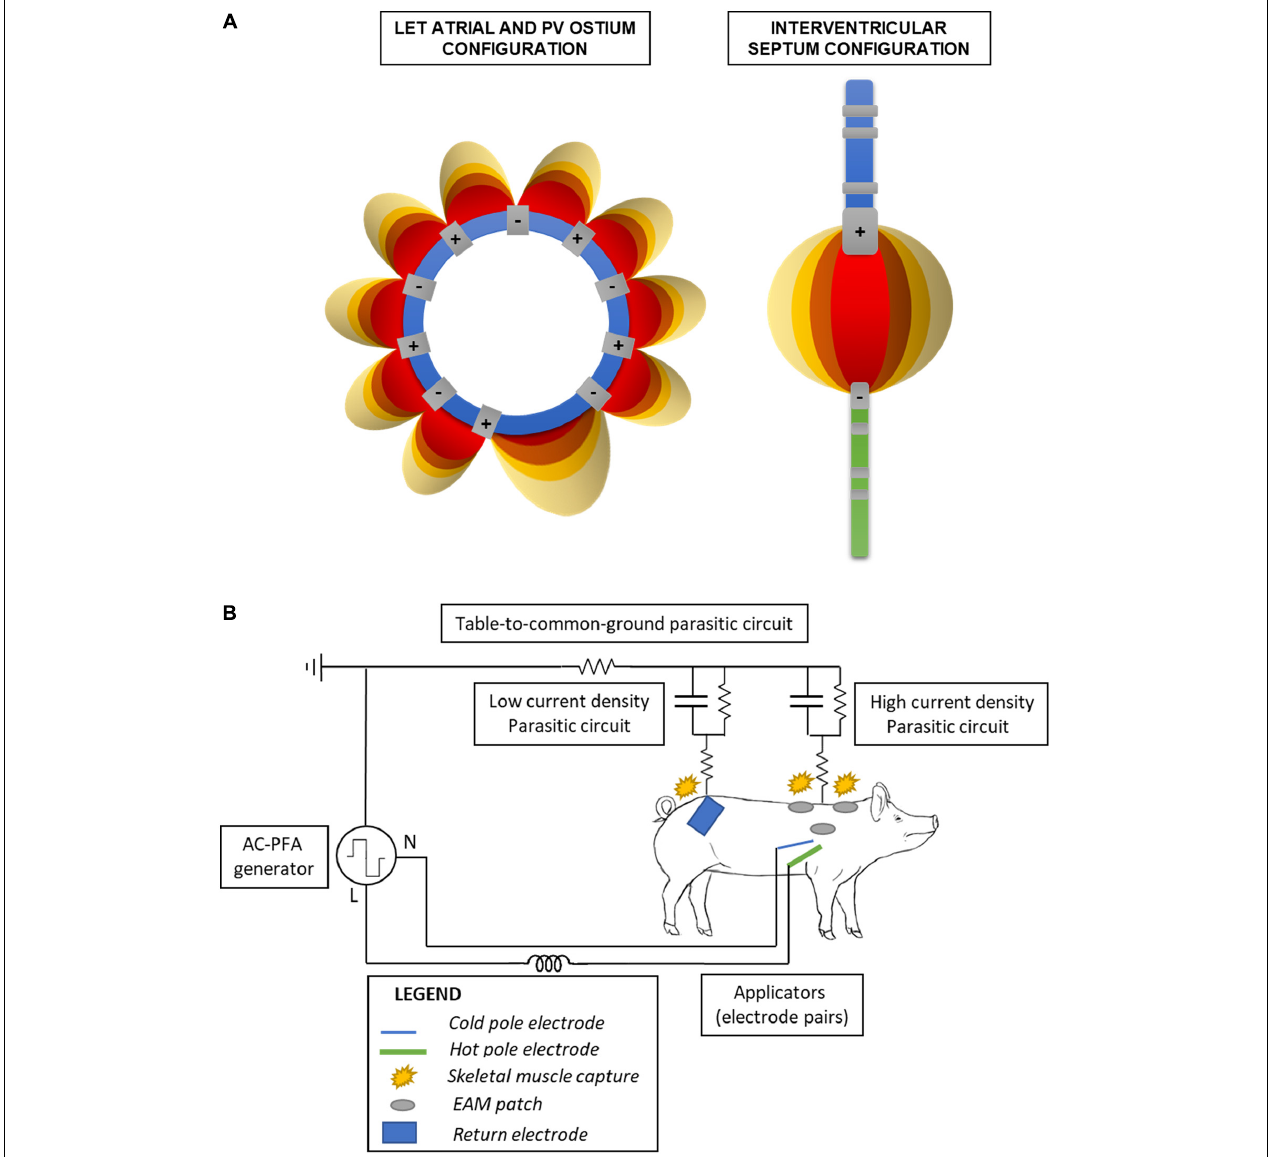
FIGURE 1 | Schematic of the electronics configuration. (A) Bipolar catheter electrodes pairings in the atrial and ventricular configuration. The electric fields internal to the loop (left) are not shown for clarity of the figure. (B) Simplified schematic of the electric circuits formed in the operating table, when employing the ventricular configuration. Parasitic circuits are present through the table to the common ground, and the return electrode favors a low impedance/current density pathway on the lower back avoiding capture of the upper limbs into muscle